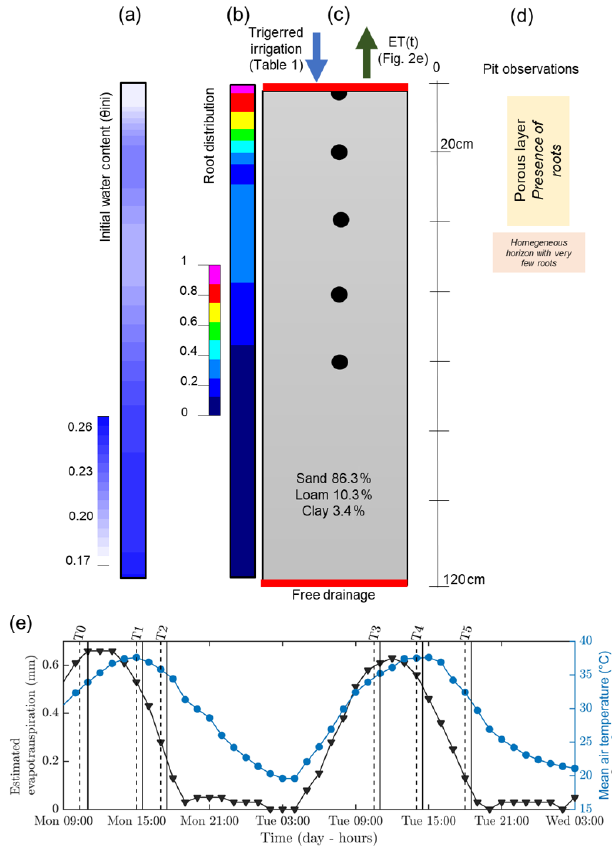
Figure 2. Initial (a, b, c) and time-varying atmospheric condi- tions used for the hydrological simulation. From left to right: (a) ini- tial conditions on soil water content θ ini , (b) root density (1cm − 1 ), (c) soil type, and (d) pit observations. (e) Variation of temperature (blue line) and estimated evapotranspiration (black line) derived from a nearby meteorological station. The vertical lines indicate ac- quisition times for plant A (dashed and plain line respectively for the start and the end of the measurement; see Table